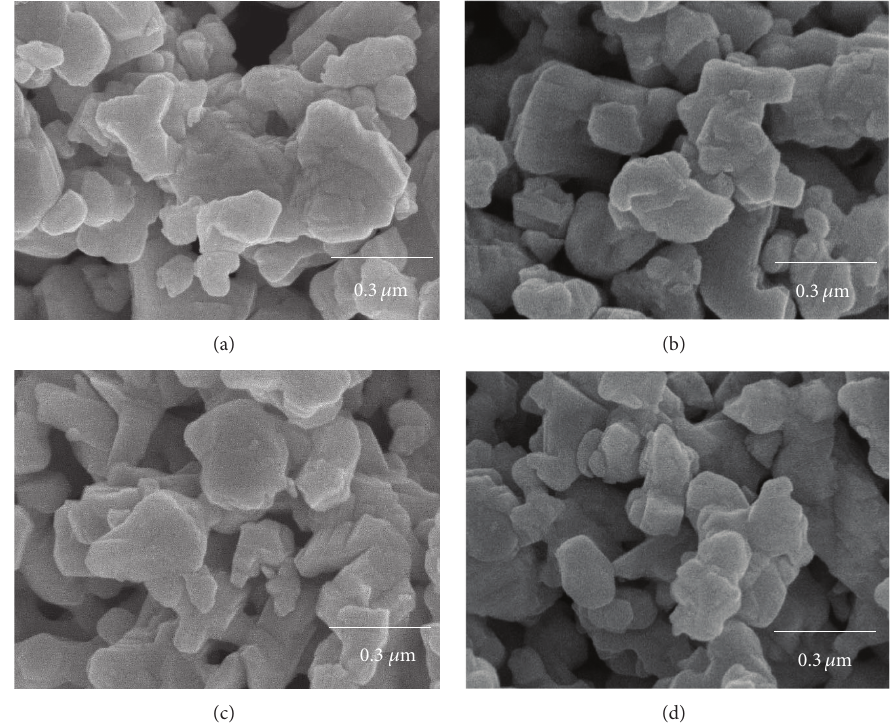
Figure 3: FE-SEM images of powders after ball milling: (a) WC, (b) WC-3wt% Fe, (c) WC-3 wt% Ni and (d) WC-3wt% Co.